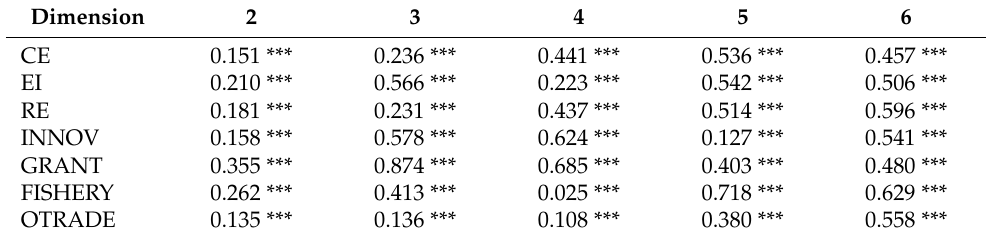
Table 6. BDS test.